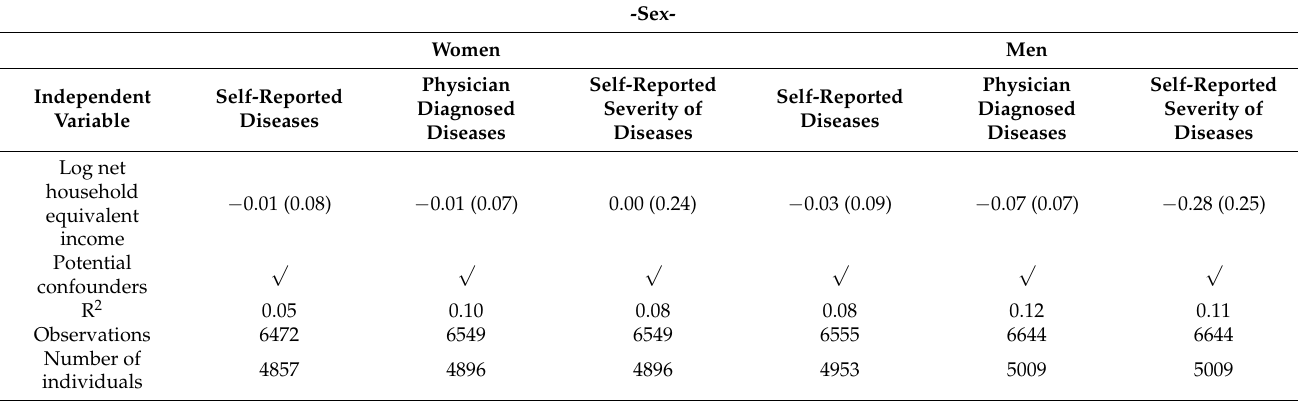
Table 3. Determinants of morbidity. Results of linear fixed-effects regressions (stratified by sex).